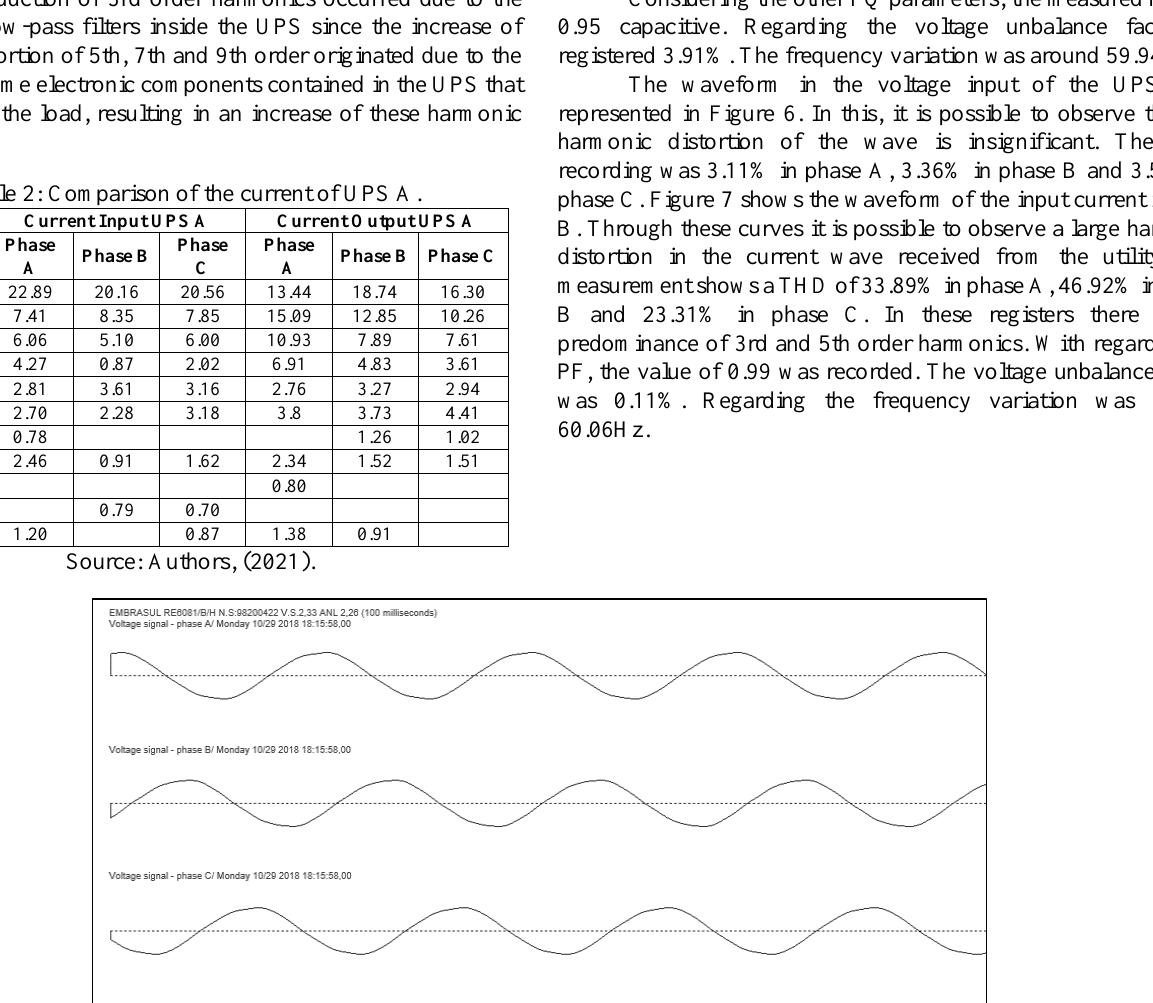
Figure 6: Voltage input to UPS